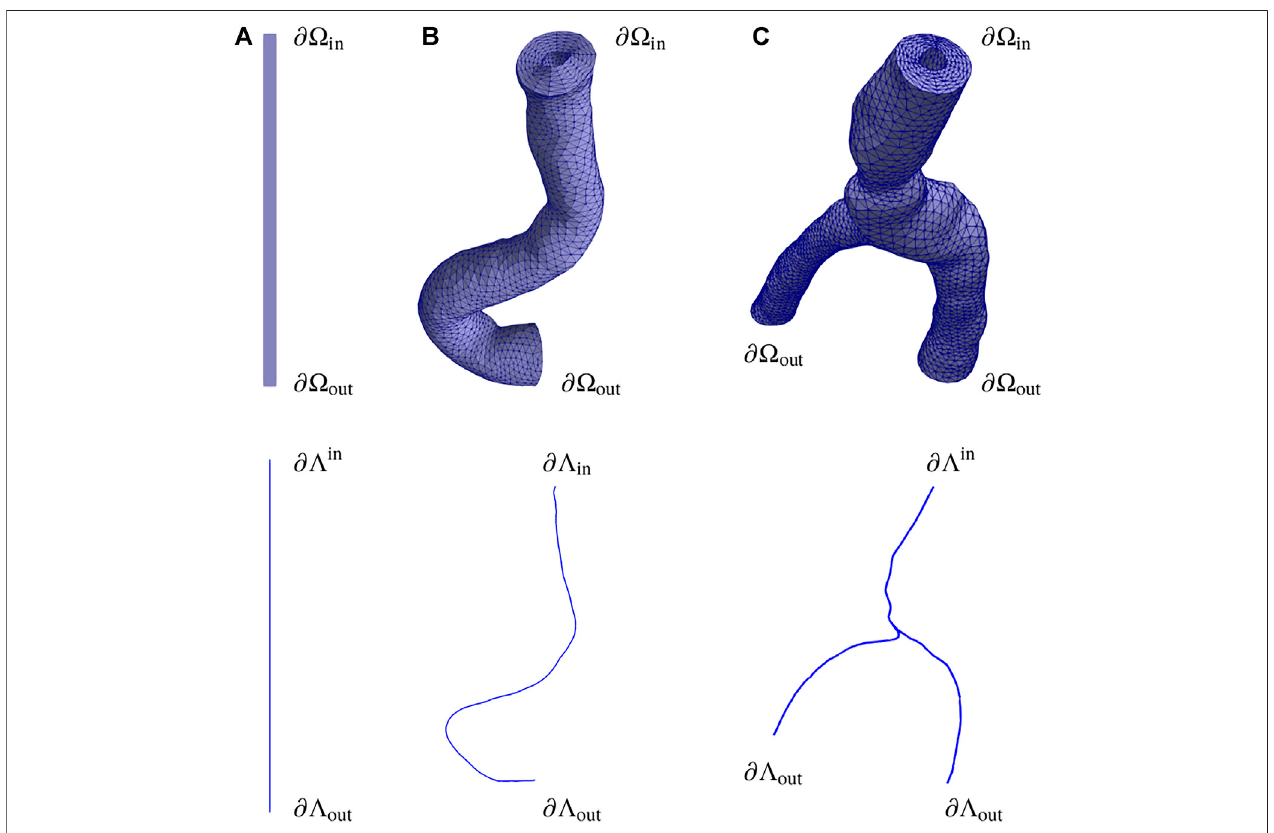
FIGURE 1 | Overview of the full three-dimensional and topologically one-dimensional reduced model domains. The idealized geometry (A) (the axisymmetric PVS ) isasingle1 mmlongaxisymmetricannularcylinderrepresentedbyitstwo-dimensional angularcross-section. Geometry (B) (the image-basedPVS )isgeneratedfroma cerebral artery segment (Aneurisk dataset repository, case id C0092) and represents an image-based perivascular space without bifurcation. Geometry (C) (the bifurcating image-based PVS ) is generated from a middle cerebral artery (MCA M1 – M2) segment (Aneurisk dataset repository, case id C0075) and represents an image-based perivascular space including a